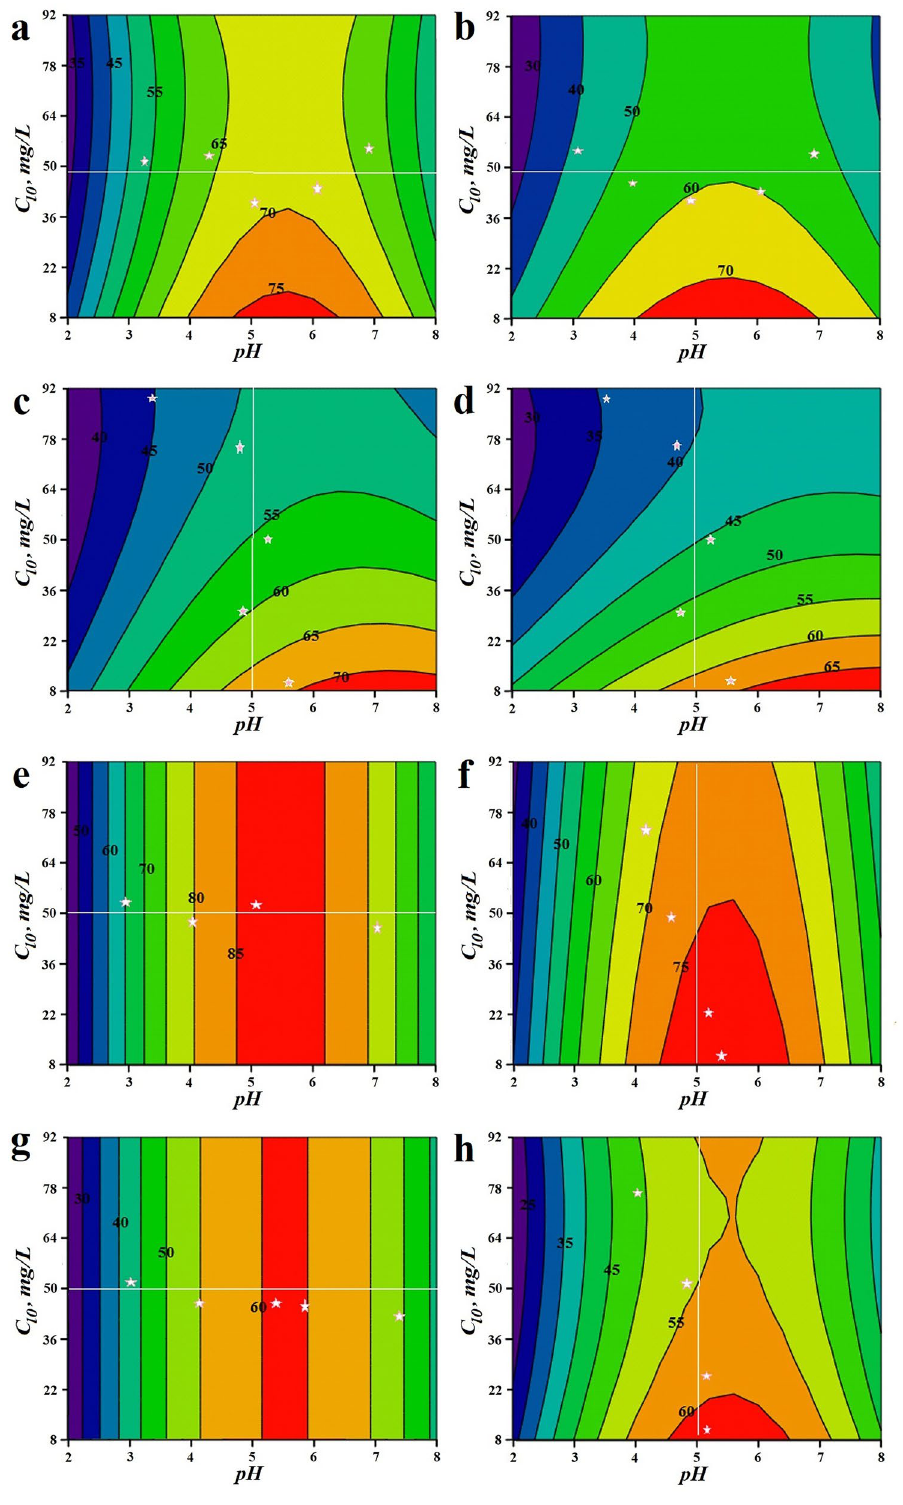
Figure 1. Influence of pH and initial Pb(II) concentration ( a , c , e , g ) / initial Cd(II) concentration ( b , d , f , h ) on separation efficiency: ( a , b ) single silent sorption, ( c , d ) competitive silent sorption, ( e , f ) single US-assisted sorption, ( g , h ) competitive US-assisted sorption. Experimental points (white stars) were obtained for d p = 0.87 mm, m HS = 8 g/l, pH from 3 to 7 ( a , b , e , g ), and c l 0 from 10 to 90 mg/l ( c , d , f , h